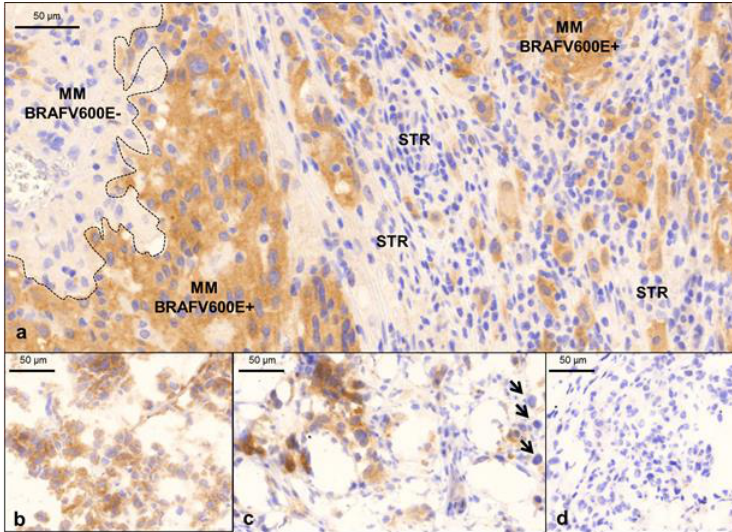
Figure 3. IHC examples obtained from melanoma patients. ( a ) Note the intratumoral heterogeneity of the FFPE tissue sample. The BRAF V600E-mutated melanoma cells display no immunoexpression of the mutated protein (left of the dashed line); whereas strong immunoexpression of the mutated BRAF protein is evident to the right of the dashed line. Stromal inflammatory cells (STR) are the negative, internal controls for staining. ( b ) Homogenous patterns of expression are shown in cryosections of fresh frozen BRAF V600E-mutated melanoma samples. ( c ) Heterogeneous patterns of expression are shown in cryosections of fresh frozen BRAF V600E-mutated melanoma samples (arrows indicate melanoma cells that are negative for the mutated protein). ( d ) A fresh frozen wild-type melanoma sample is the negative control for the IHC method.